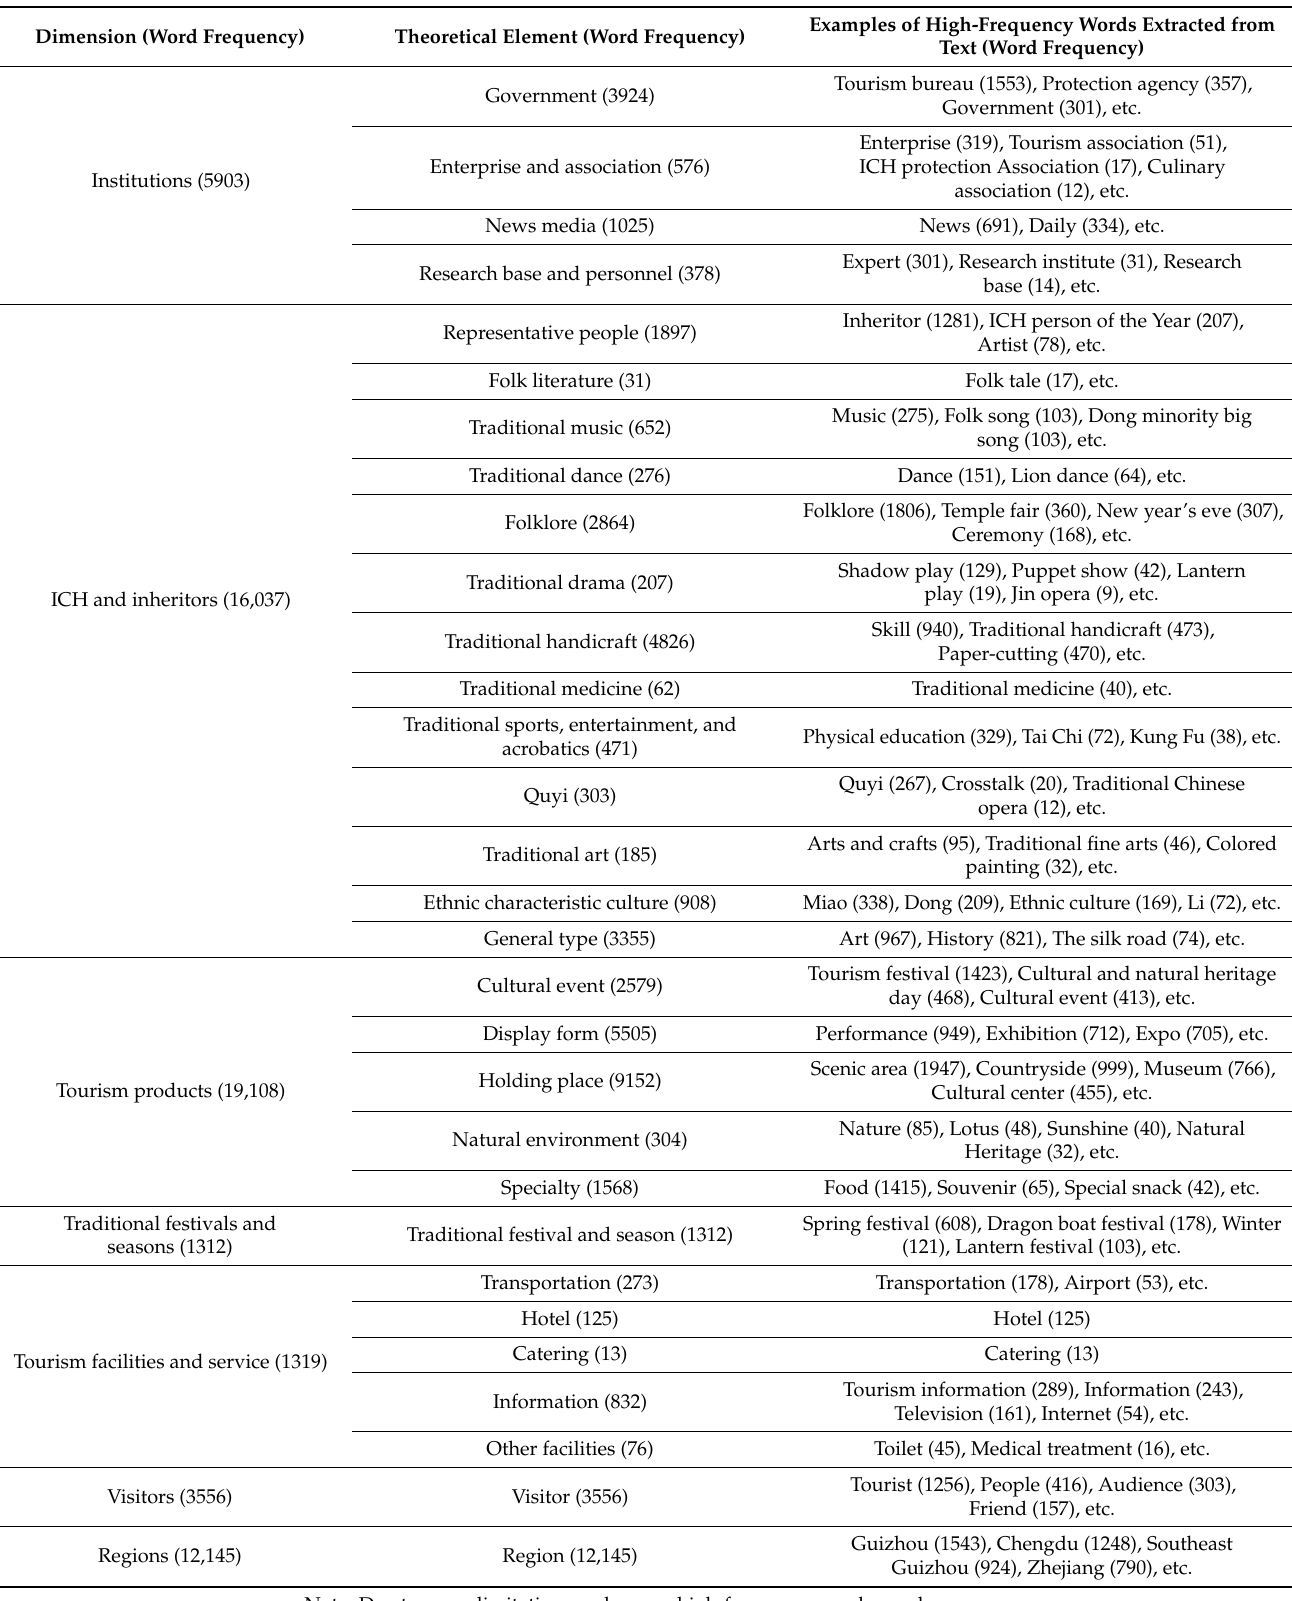
Table 2. High-frequency words, theoretical elements, and dimensions conveying cognitive attributes of ICH